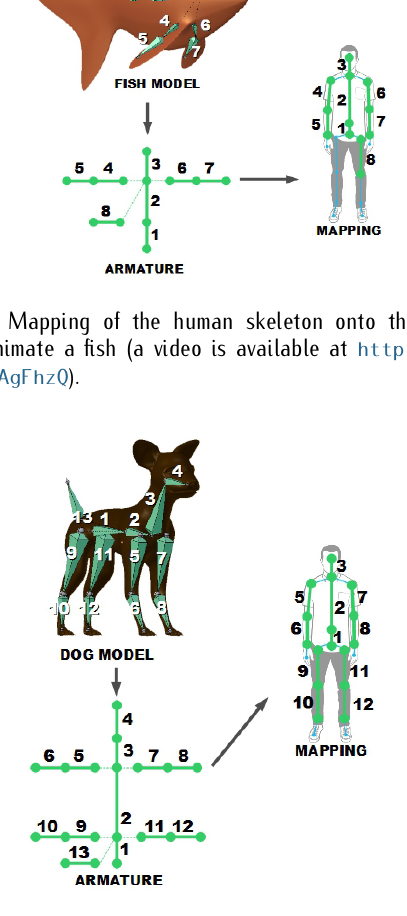
Figure 5. Mapping of the human skeleton onto the armature used to animate a dog (a video is available at http://youtu. be/cQIKeOAwN24